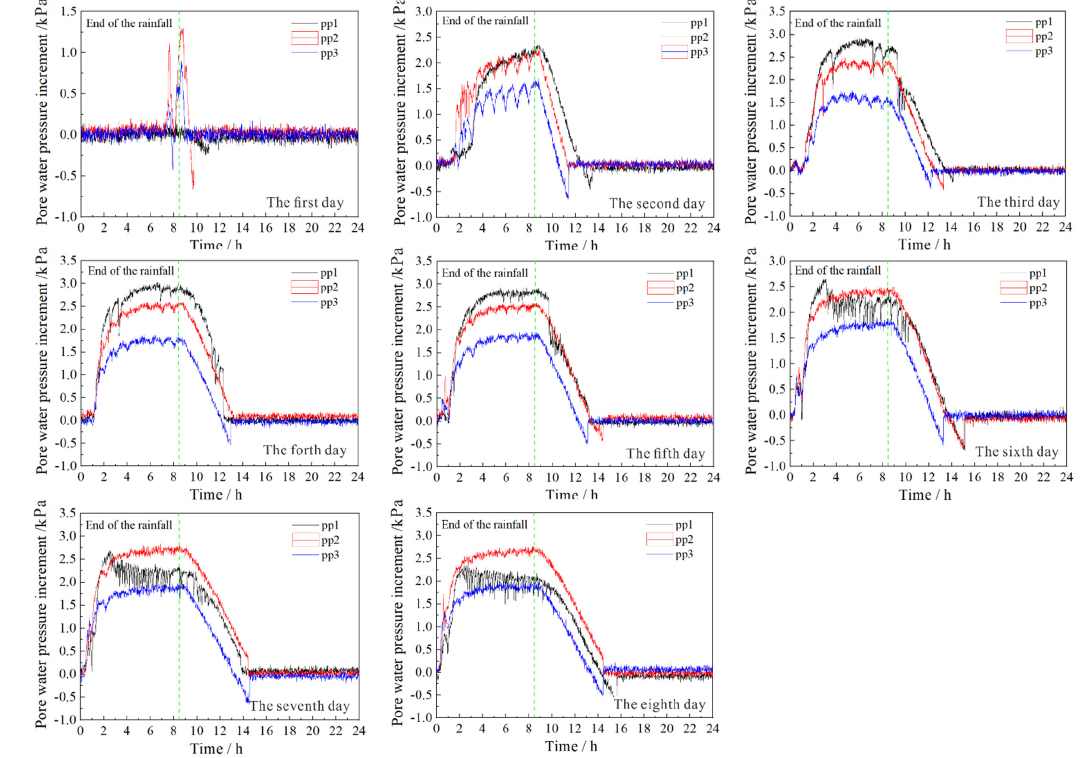
Land 2022 , 11 , x Figure 7. Variation of pore water pressure in the following days, from the first to the eighth (H1 = 1.0 m). 3.2.2. Variation of Pore Water Pressure in Middle and Upper Slope (H2 = 0.8 m)